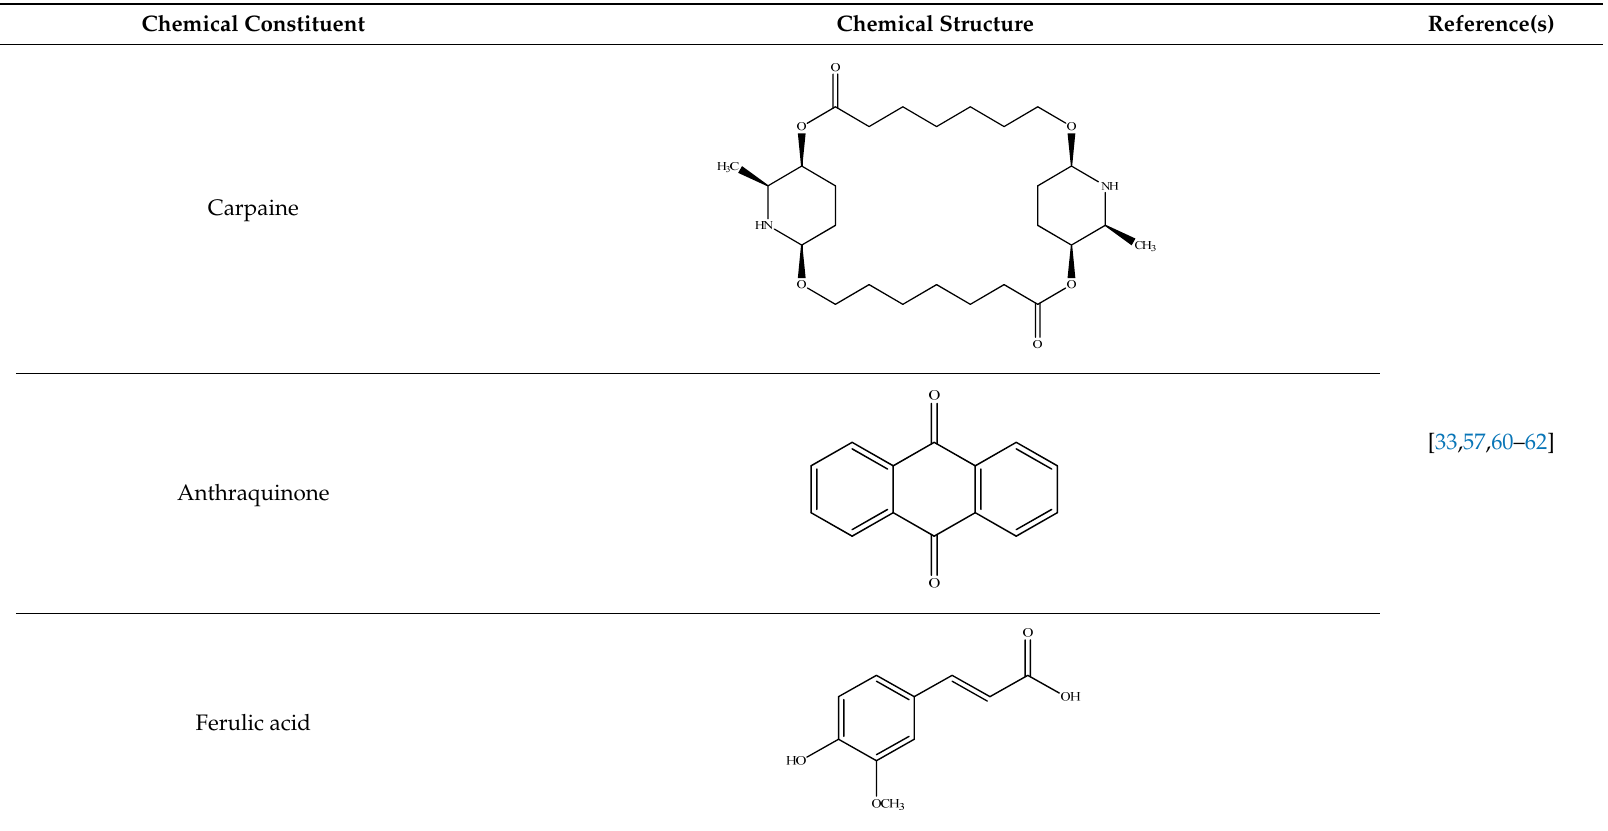
Table 2. Leading phytochemicals isolated and characterized in C. papaya plant.